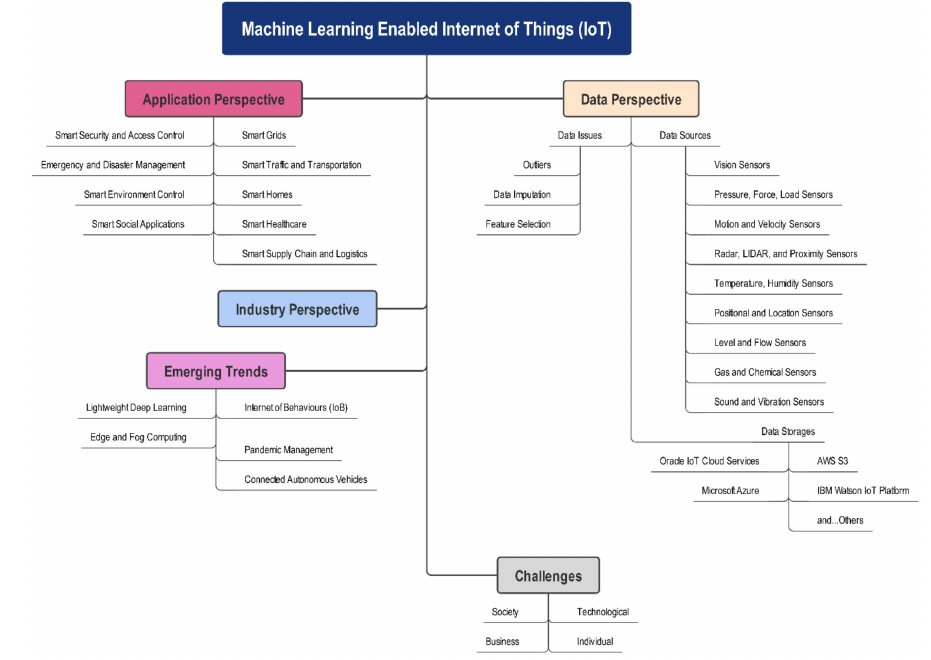
Figure 3. The high-level structure of the